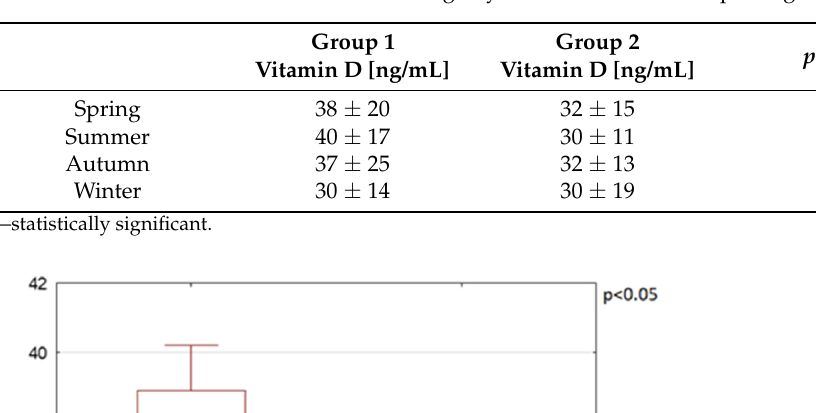
Table 1. Mean vitamin D serum level according to year seasons in the compared groups.